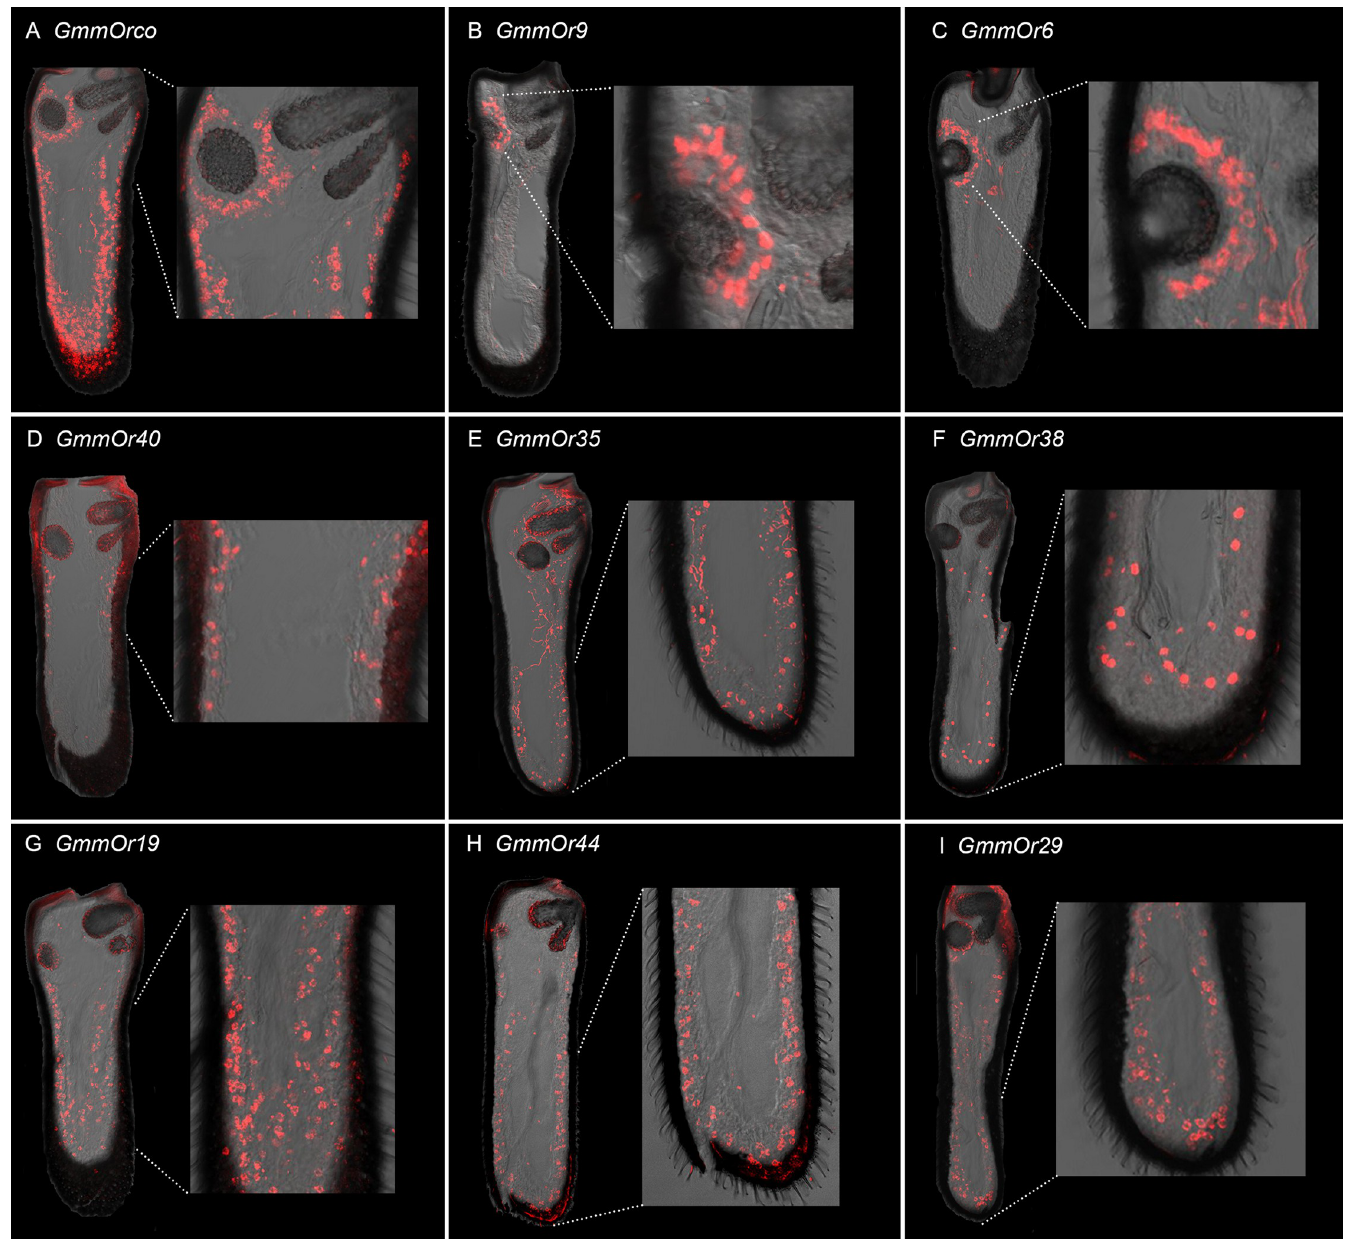
Fig 5. Expression of GmmOrs in the antenna. For all images dorsal is up and medial is to left. (A) GmmOrco . (B) GmmOr9 . (C) GmmOr6 . (D) GmmOr40 . (E) GmmOr35 . Some background fluorescence is visible that does not emanate from cell bodies; see sense strand control in S1H Fig. (F) GmmOr38 . (G) GmmOr19 . (H) GmmOr44 . (I) GmmOr29 . We note that in several of these images there is background fluorescence that emanates from the cuticle, which is thicker in the antenna of G . morsitans than in D . melanogaster . See S1 Fig for sense strand